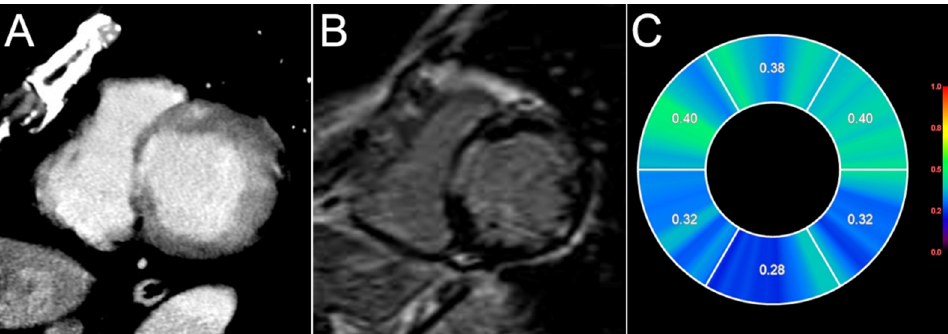
Figure 6. T1 mapping on MRI and delayed contrast-enhancement CT. A case of cardiac sarcoidosis. Short-axis views of delayed-enhancement CT ( A ), late gadolinium enhancement (LGE) on MRI ( B ), and the extracellular volume (ECV) map obtained pre- and post-enhancement at similar levels ( C ). Abnormal patchy enhancement in the anteroseptal, septal, and lateral wall was detected by delayed-enhancement CT. LGE can also reveal obvious hyperintensity areas consistent with CT. Higher ECV values corresponded to LGE.